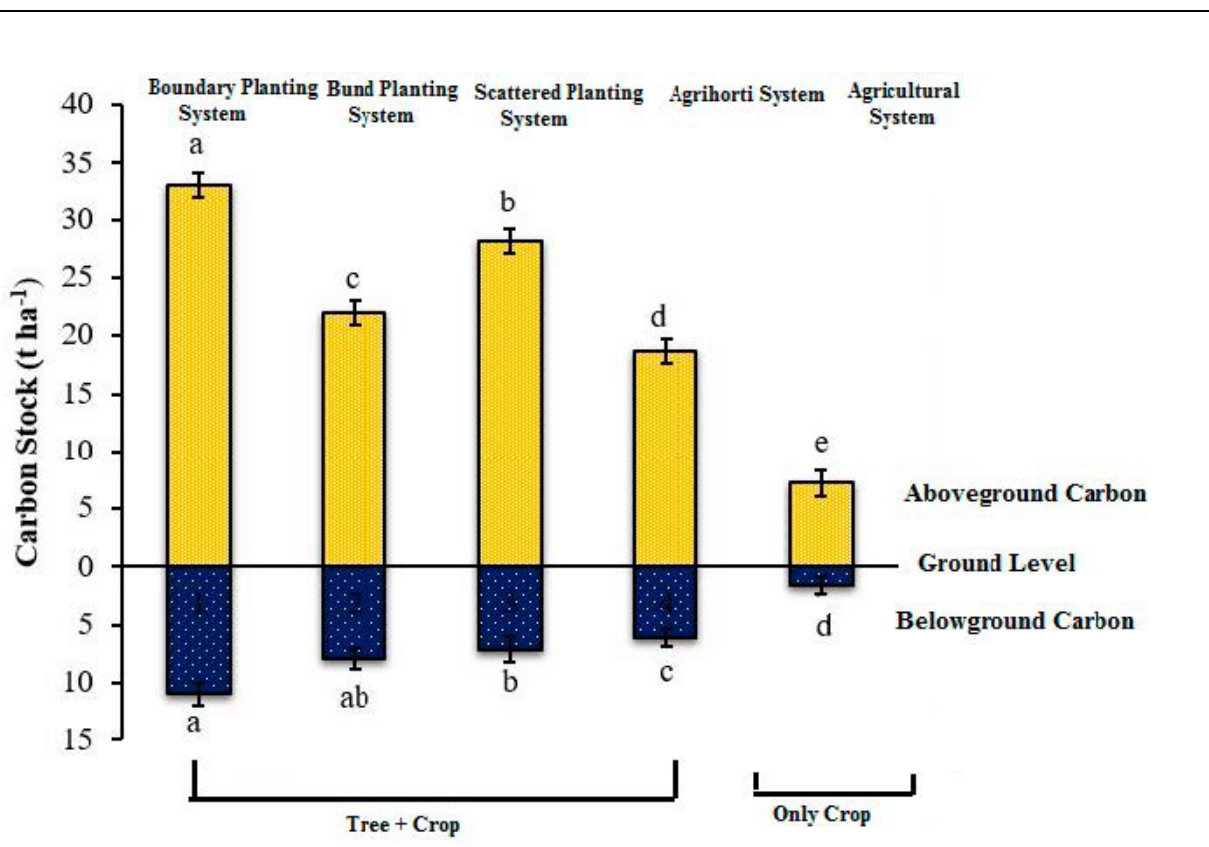
Figure 2. Distribution of biomass carbon stocks among different agroforestry systems in the semi-arid region.